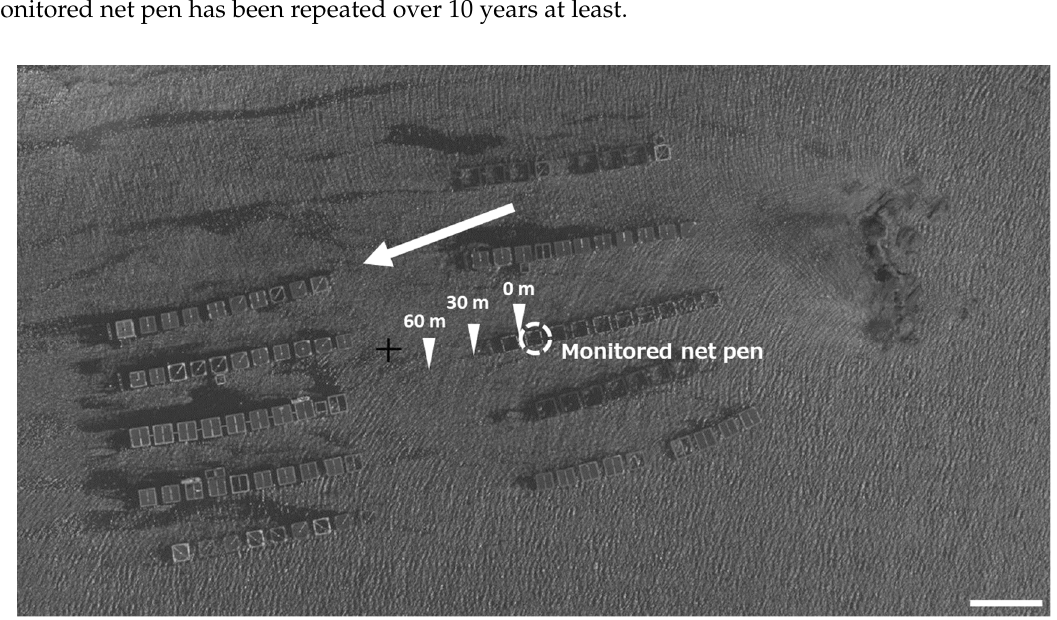
Figure 1. Sampling Locations. The circle indicates the monitored net pen. Samples were collected 0 m, 30 m, and 60 m (arrowheads) from the net pen along the water current. The dominant current direction in this site is indicated by an arrow. This map is based on an aerial photograph published by the Geospatial Information Authority of Japan. Scale bar: 50 m.